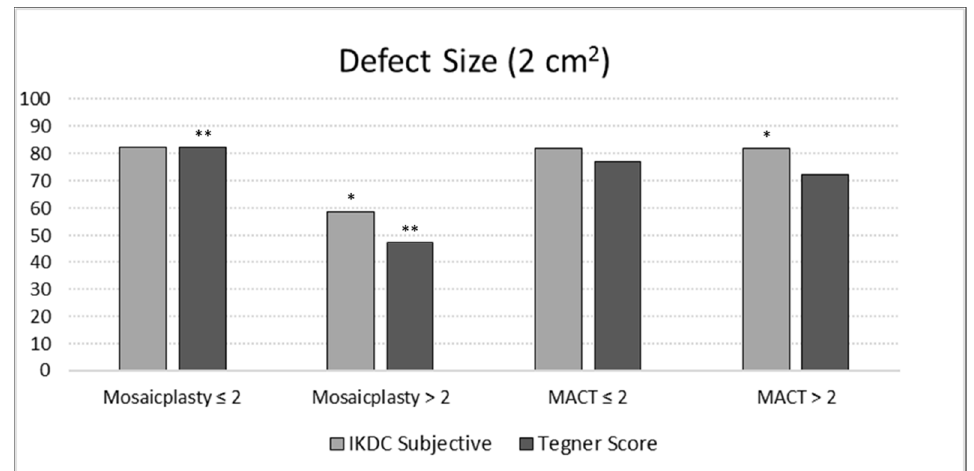
Figure 5. Evaluation of the defect size effect on the International Knee Documentation Committee (IKDC) subjective score and the percentage Tegner Score improvement at a final follow-up of 12 years in both groups of patients. The asterisk (*) indicates for the MACT group a tendency for higher subjective results compared to the mosaicplasty group for the defect area > 2 cm 2 (p = 0.092). The double asterisk (**) indicates a lower improvement in terms of Tegner Score for the defect area > 2 cm 2 in the mosaicplasty group (p = 0.014).